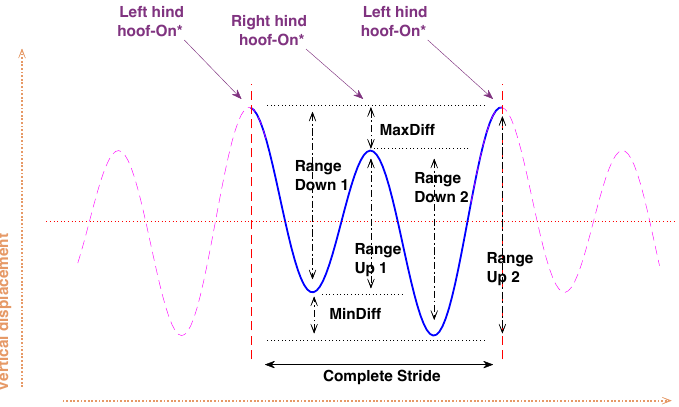
Figure 4. Upper-body vertical displacement annotated with symmetry parameters. The timing of hoof-on instances is